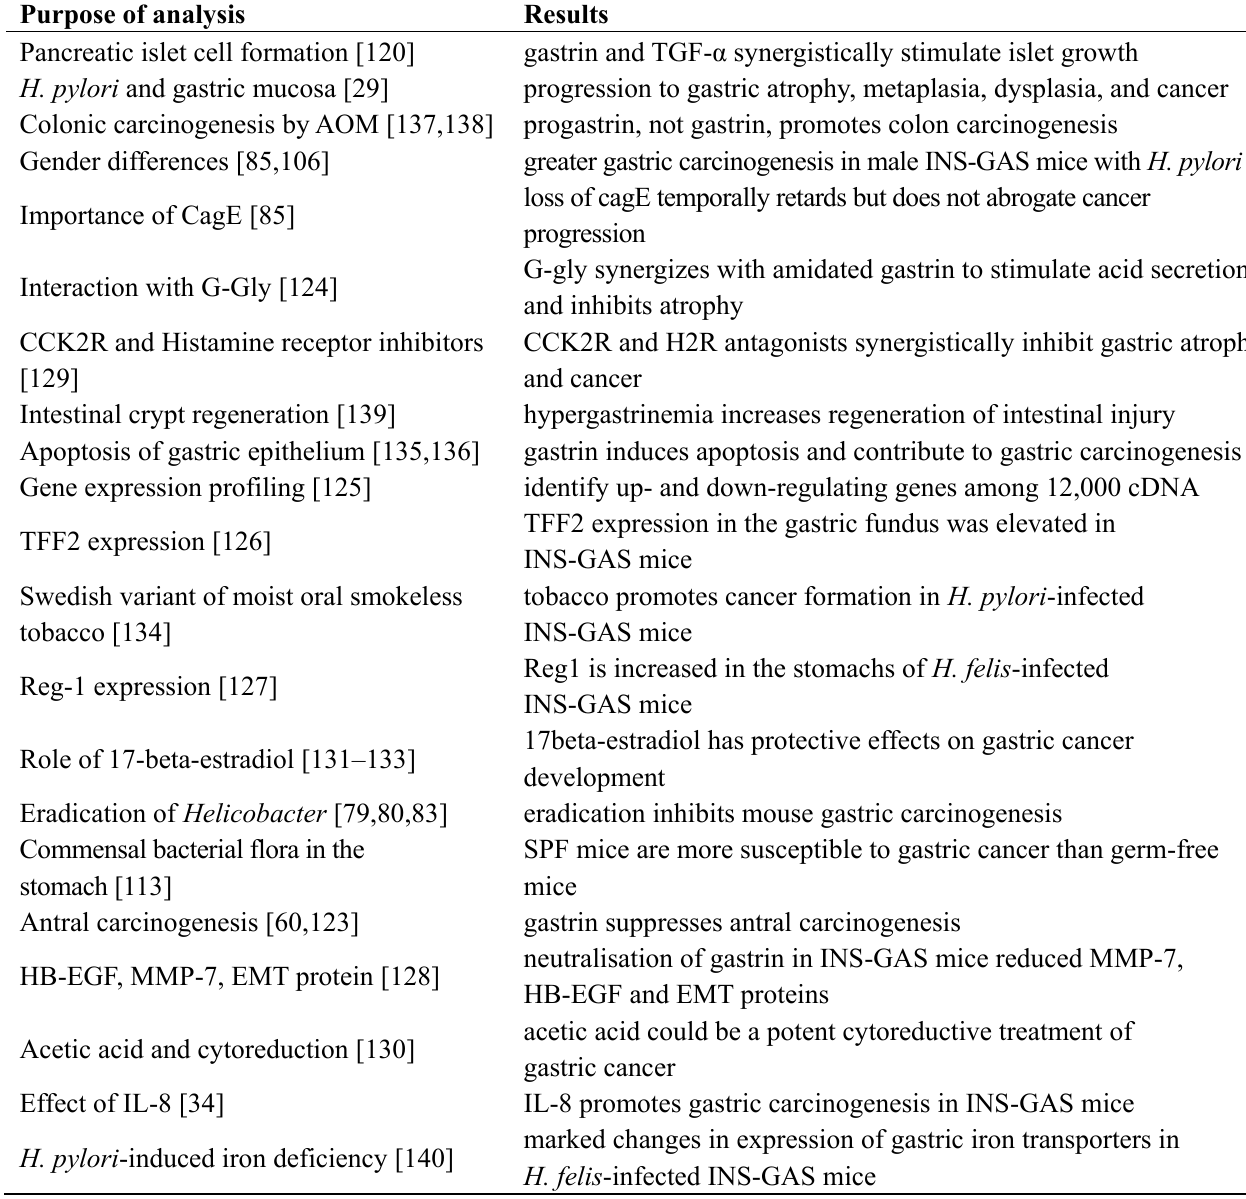
Table 1. Applications of INS-GAS mouse